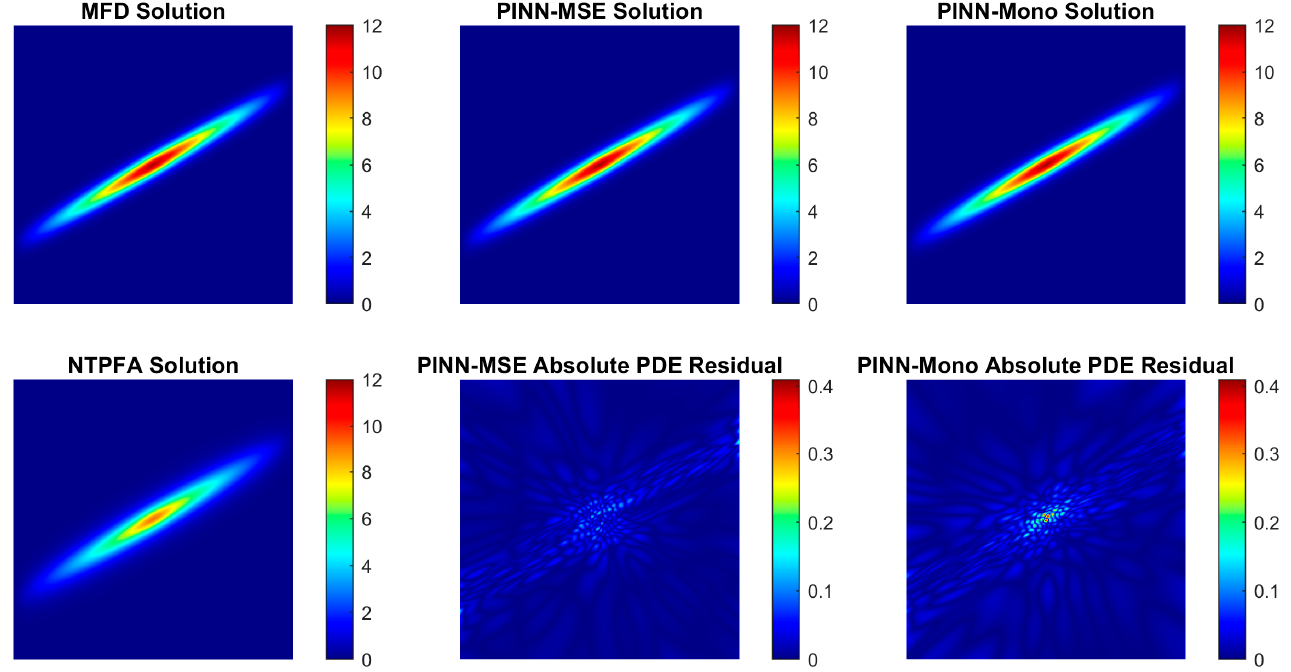
Figure 8. Results of case 1: θ = π . The first column shows the solution of MFD and NTPFA. The second and third columns show the solution and absolute PDE residual of PINN-MSE and PINN-Mono, respectively.